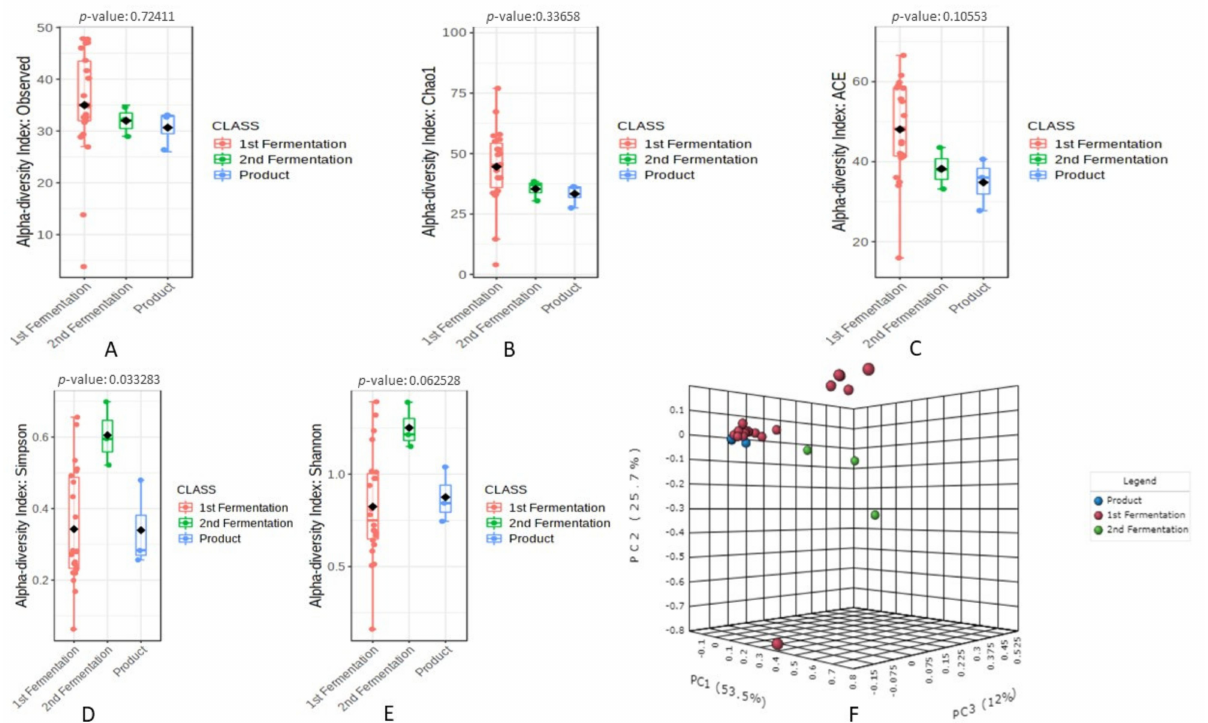
Figure 1. Comparison of bacterial community diversity among the fermentation stages and final product. Alpha diversity was measured by Observed ( A ), Chao1 ( B ), ACE ( C ), Simpson ( D ), and Shannon ( E ) diversity indices whereas, beta diversity was evaluated using PCoA (3D) ordination ( F